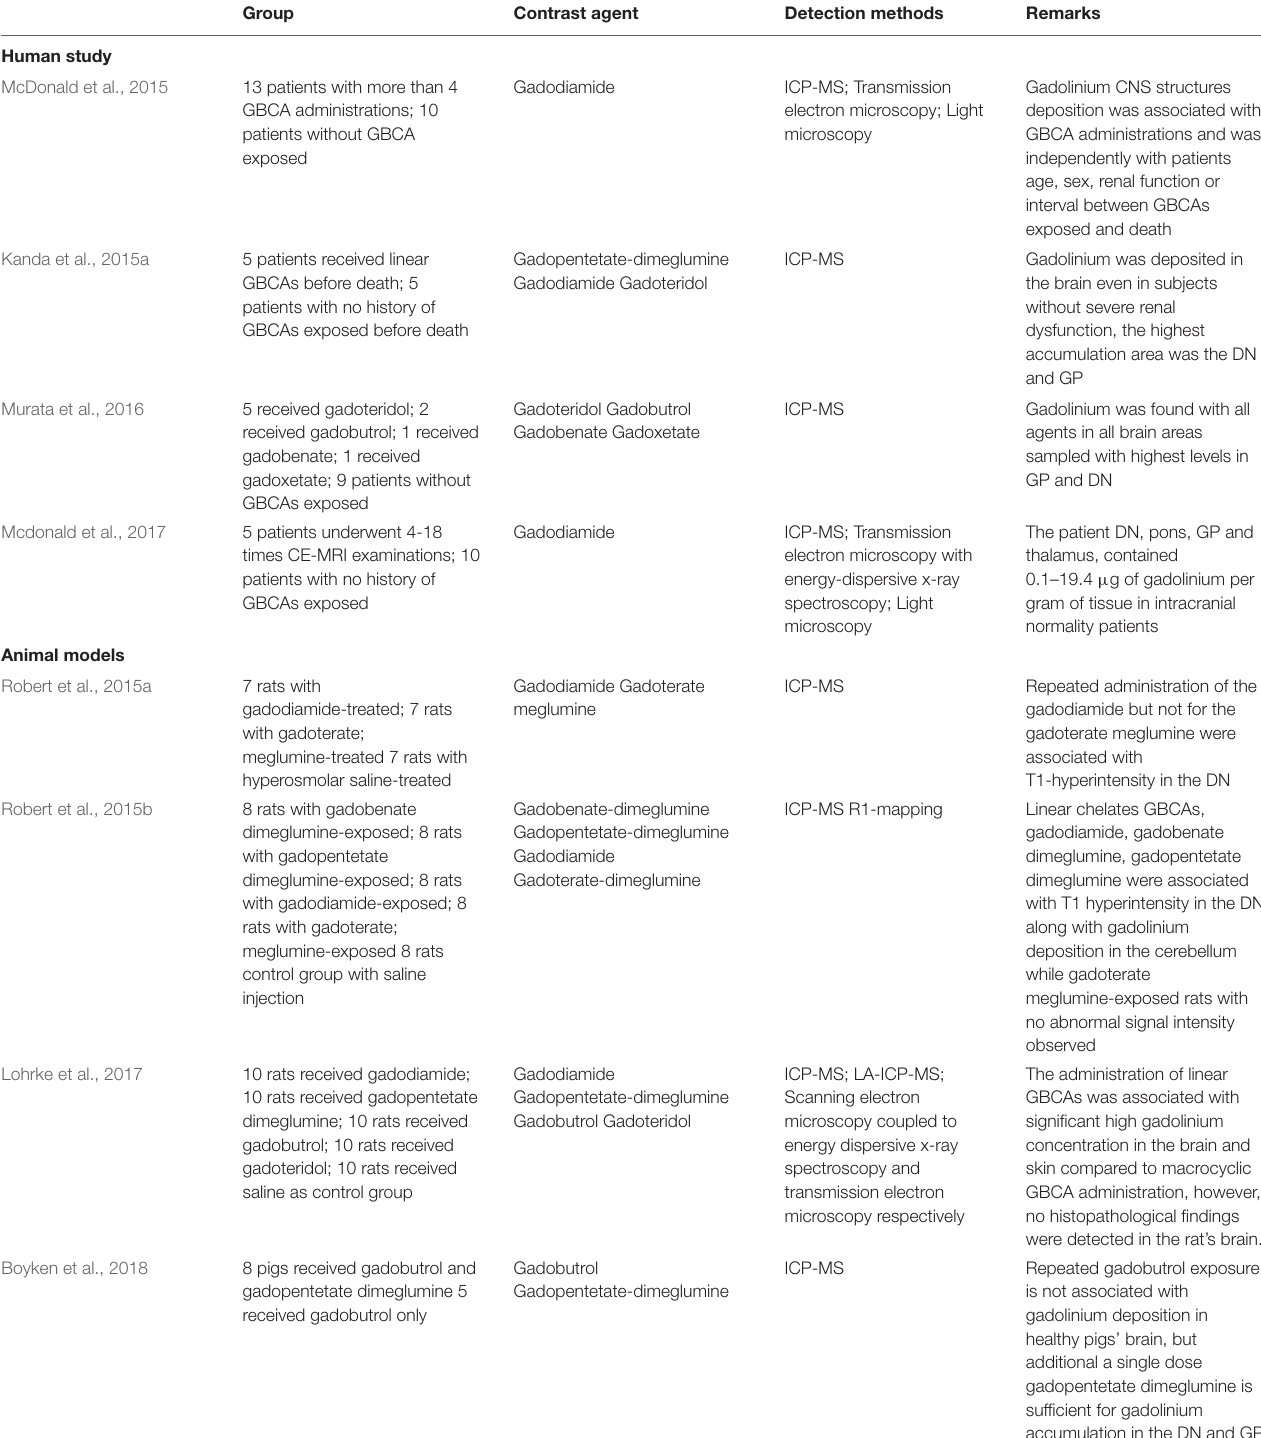
TABLE 3 | Autopsy studies in human or animal